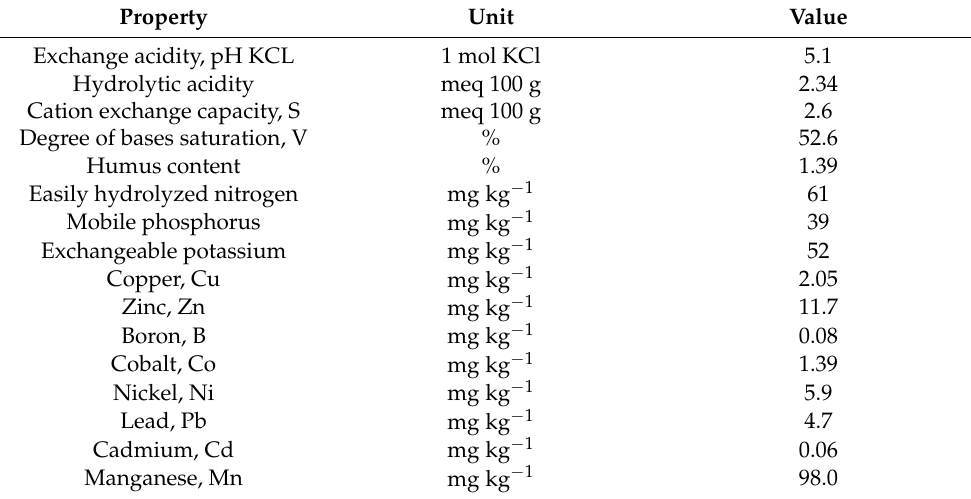
Table 1. Soil characteristics of the experimental